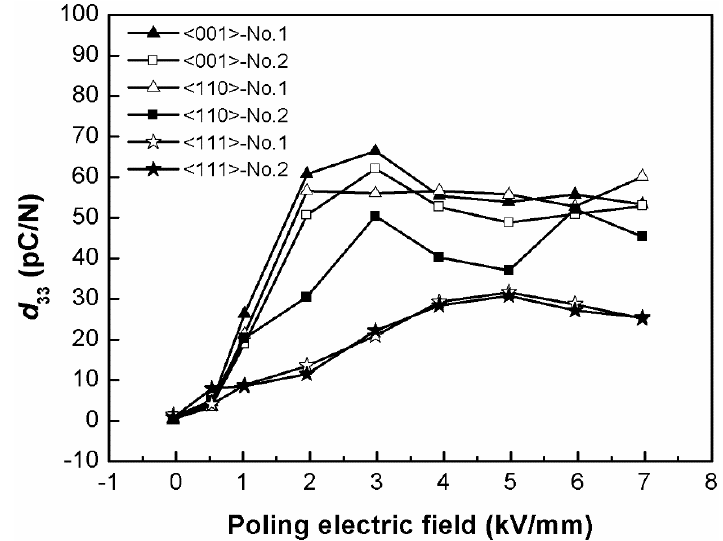
Figure 6. Piezoelectric constants d 33 as a function of poling electric field for <001>, <110> and <111> oriented NBT-BT 98/2 crystal. Reprinted with permission from [24]. Copyright 2008 Elsevier.